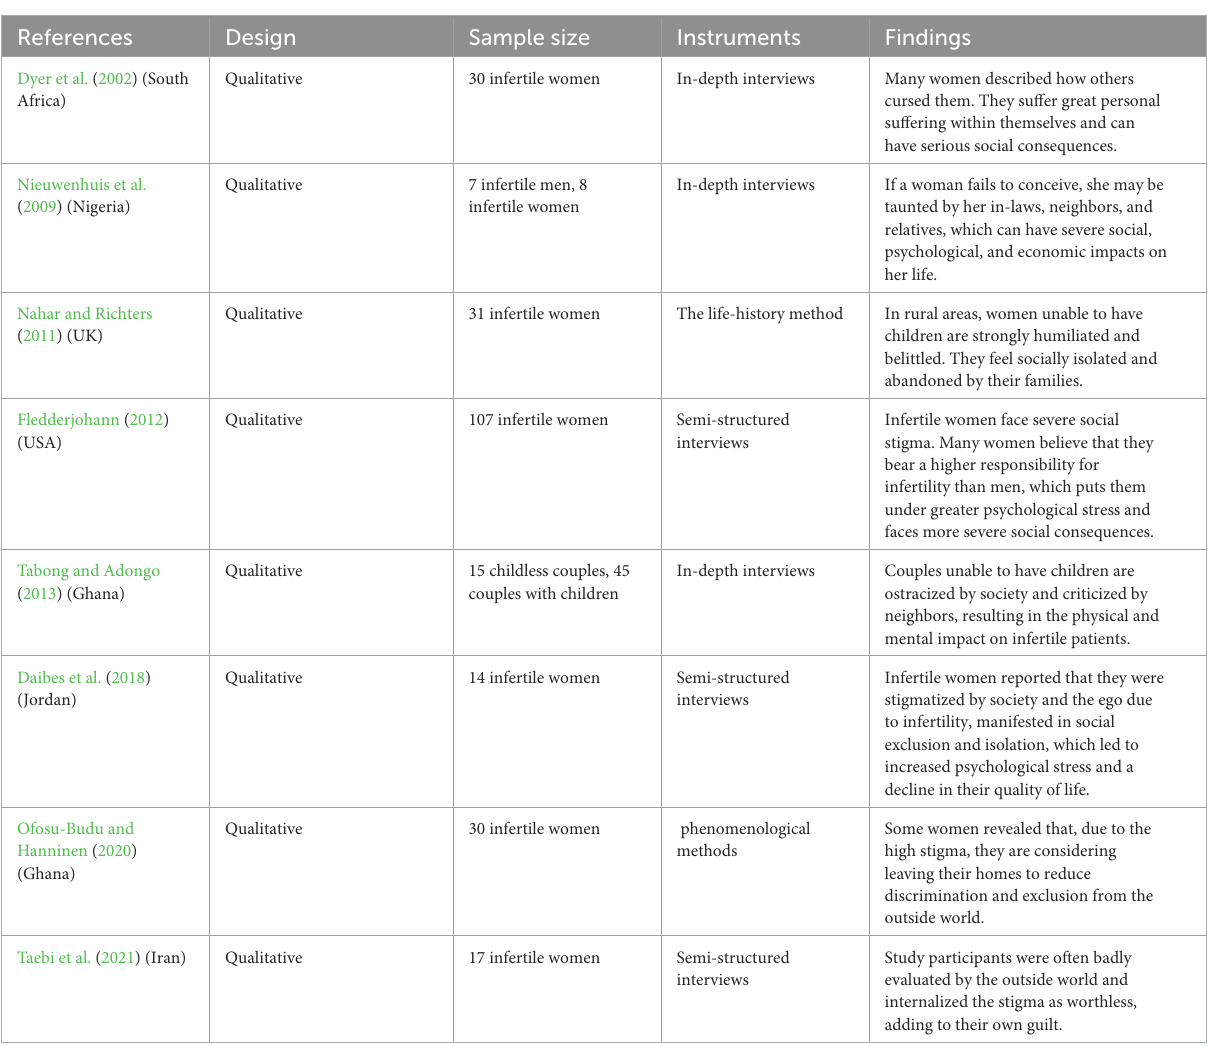
Tabong and Adongo (2013)